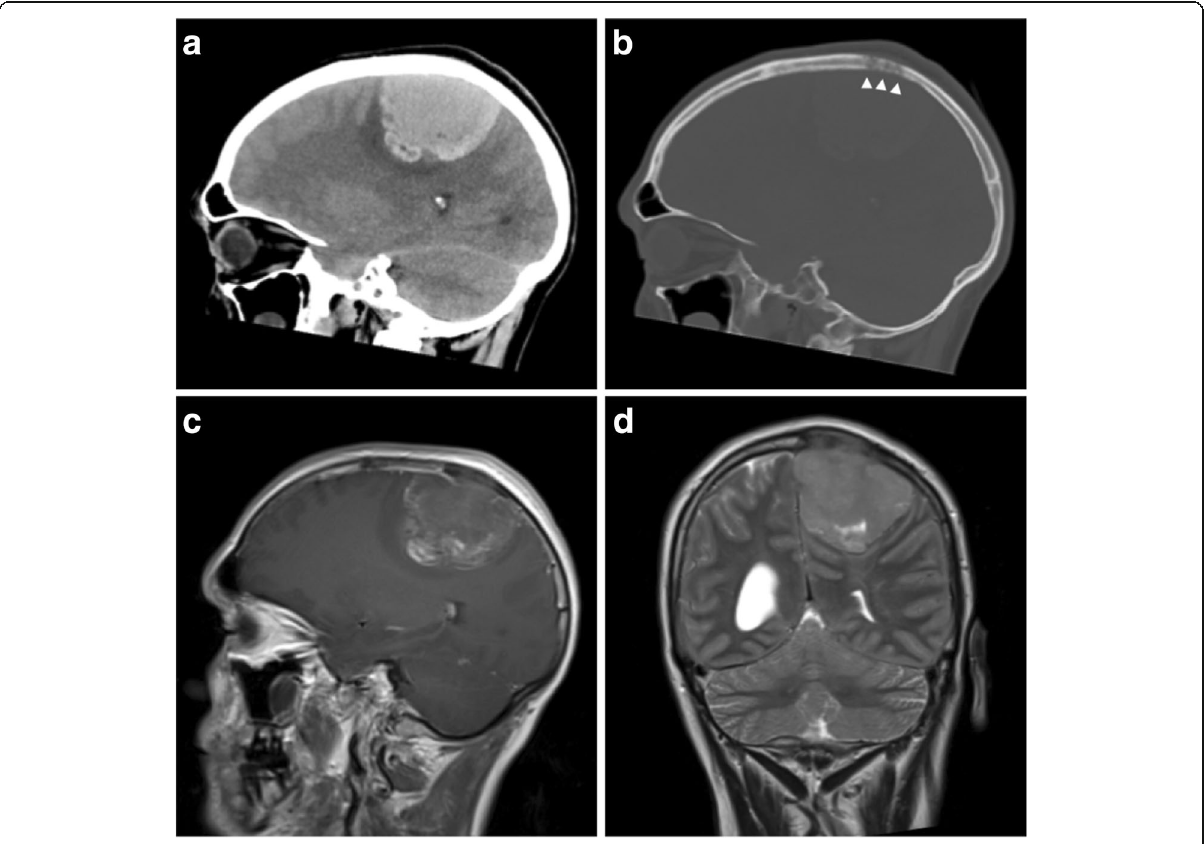
Fig. 5 Non-germ cell seminoma metastasis. a Sagittal unenhanced CT image showing an irregular and hyperdense extra-axial mass with a wide dural attachment and only minimal vasogenic oedema. b Sagittal CT image on the bone windowing showing bony destruction adjacent to the lesion (white arrowheads) and no hyperostosis. c Post-contrast sagittal T1-weighted MR image showing only minimal irregular peripheral enhancement and no dural tail. The sagittal sinus is involved and occluded. On unenhanced T1-weighted images, the lesion was isointense to white matter and contained small areas of T1-shortening consistent with haemorrhage. d Coronal T2-weighted image of the same